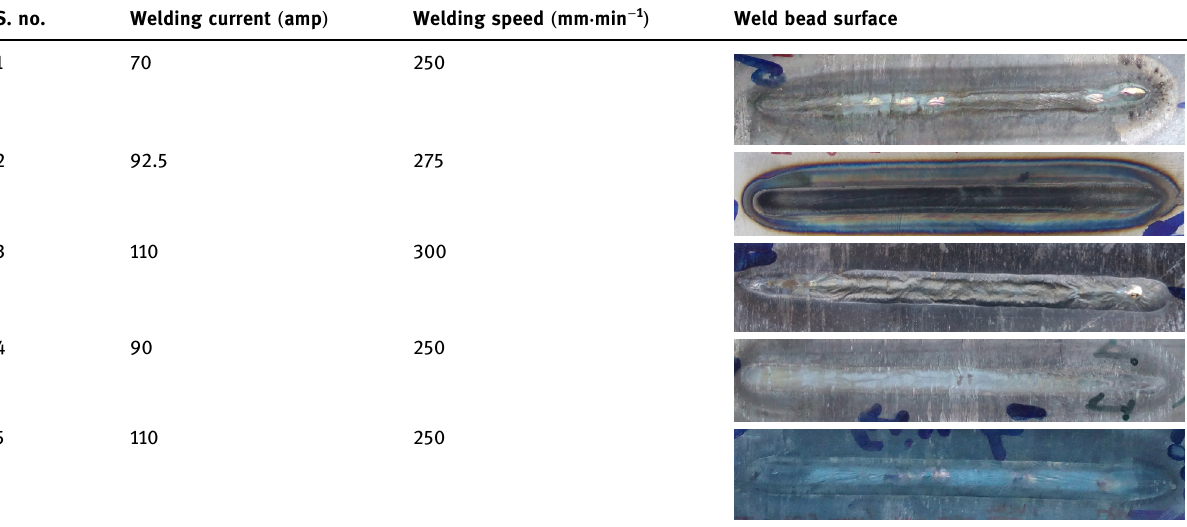
Table 1: Weld bead surface obtained at various combinations of inputs S. no.